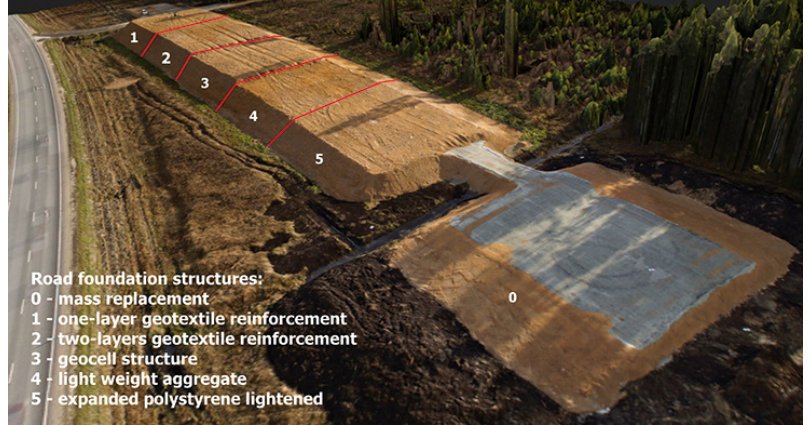
Figure 1. 3D model of the Võõbu test site embankment (volume ~ 17000 m 3